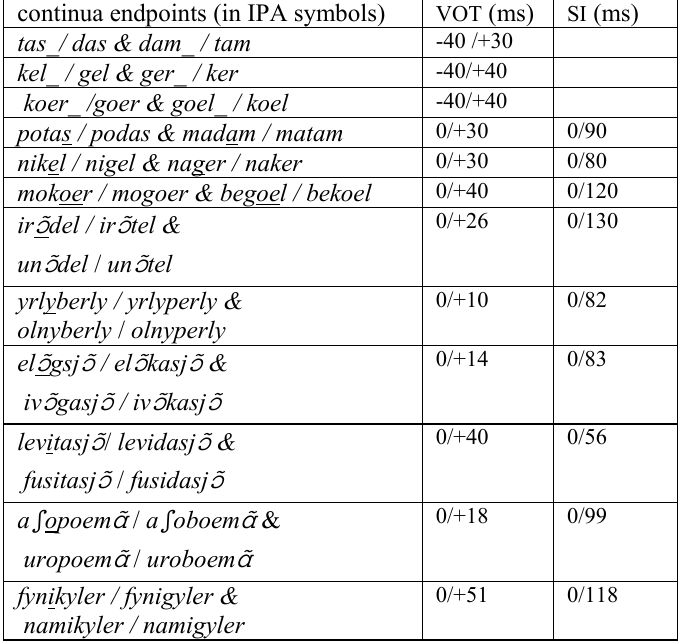
Table II: VOT (Voice Onset time) and SI (Silent Interval during closure) characteristics of the stimuli in Exps. 1 and 2. For the word stimuli, the location of the Uniqueness Point (UP) is underlined. The first number in each cell corresponds to voiced endpoint and the last one to the voiceless